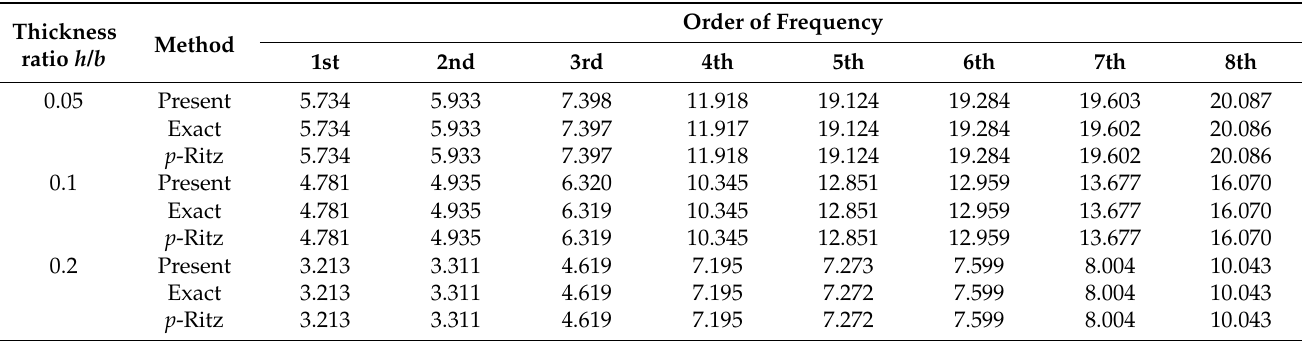
Table 7. The nondimensional frequency Ω for SFSF